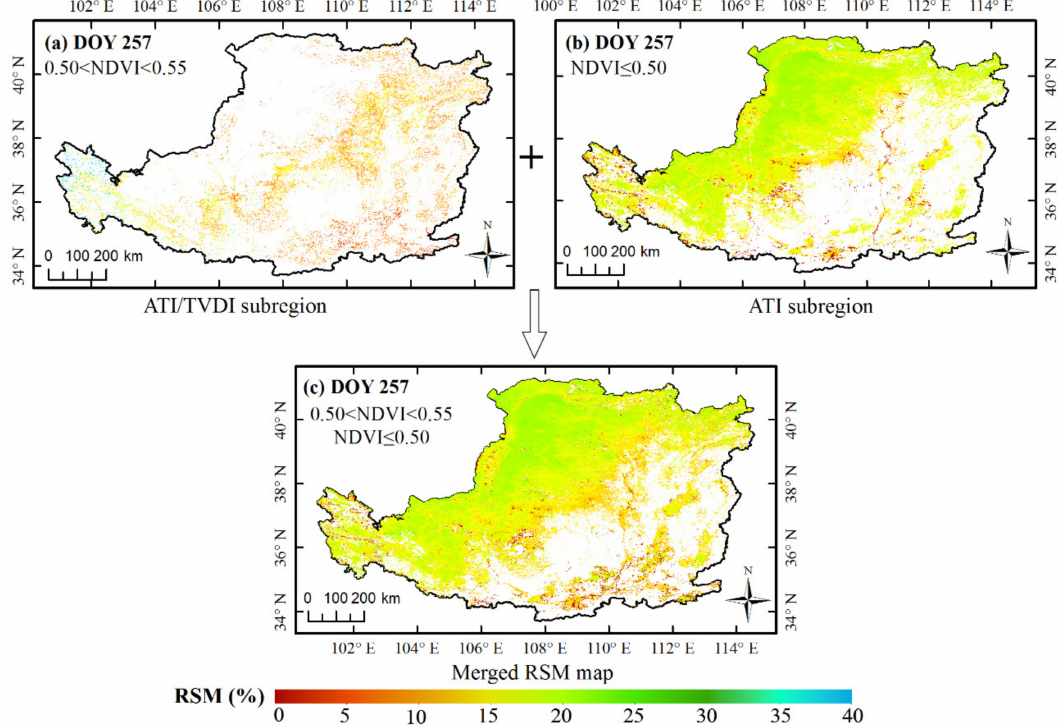
Figure 7. The RSM map was produced by merging the RSM of two subregions on DOY 257. ( a ) The RSM map of ATI / TVDI subregion, ( b ) the RSM map of ATI subregion, ( c ) the merged RSM map of the